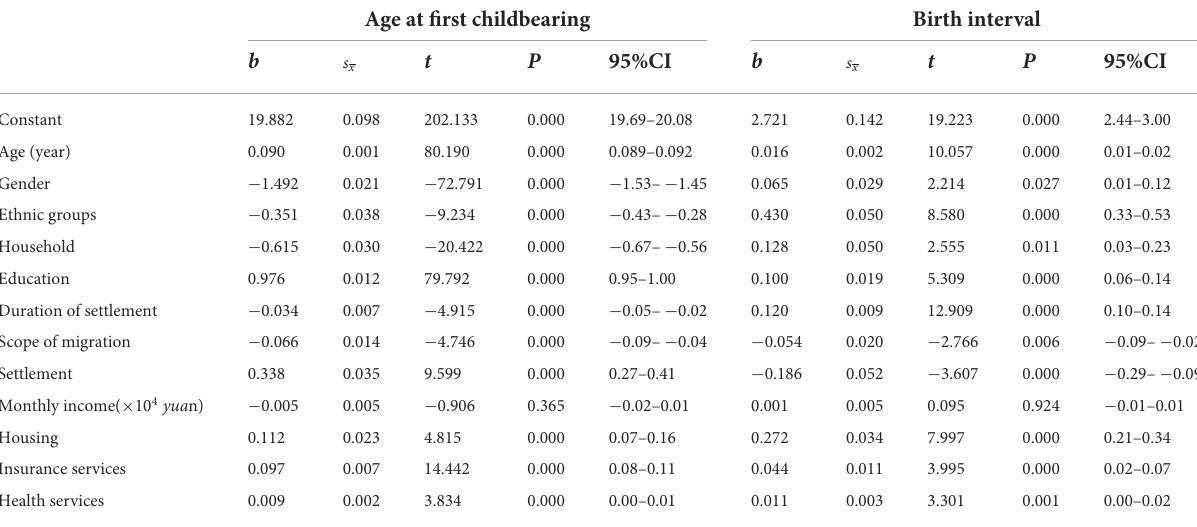
TABLE 6 Associated factors of age at first childbearing and birth interval of floating population.